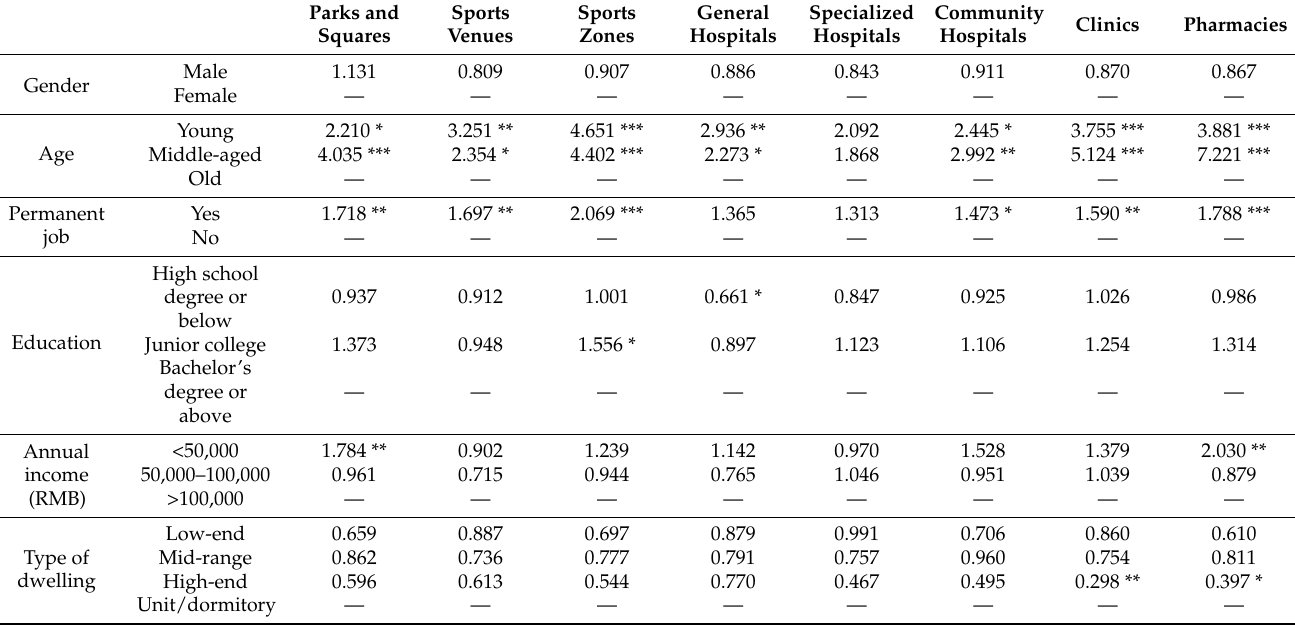
Table 5. Ordinal logistic model parameters for satisfaction with